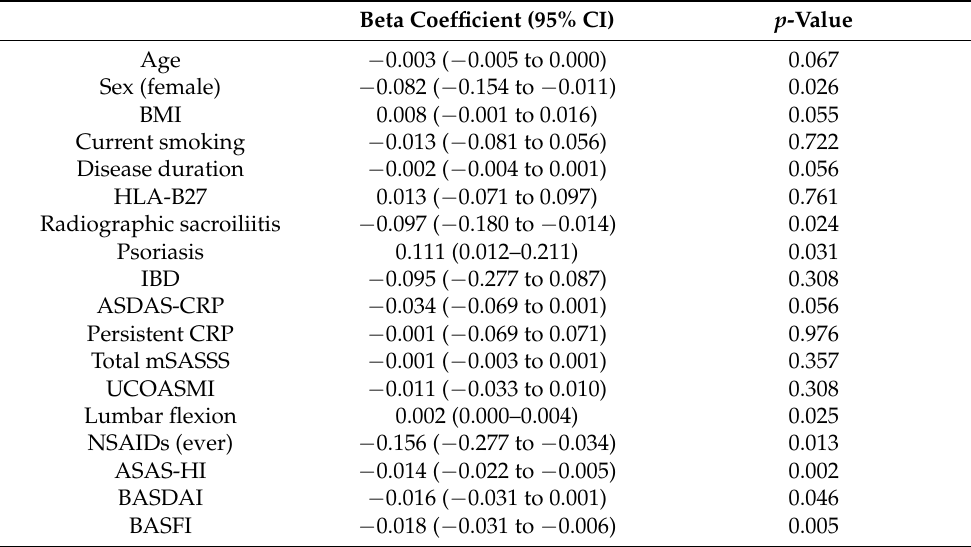
Table 4. Univariate generalised linear regression to evaluate the factors associated with total hip bone mineral density.